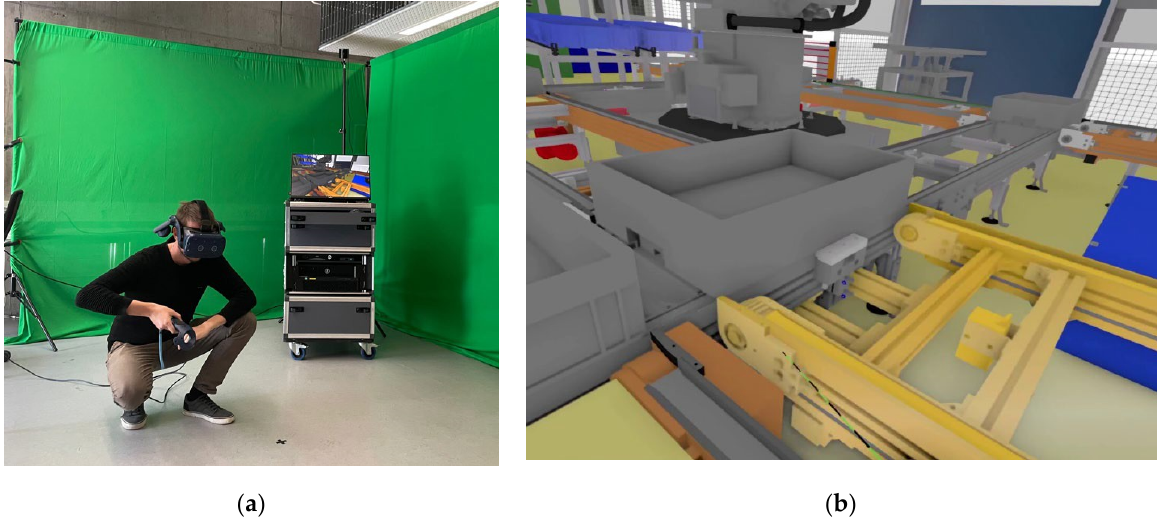
Figure 2. ( a ) Environment for the VR session. ( b ) Field of view in VR. The less experienced service technician then joins the session with an AR Headset.